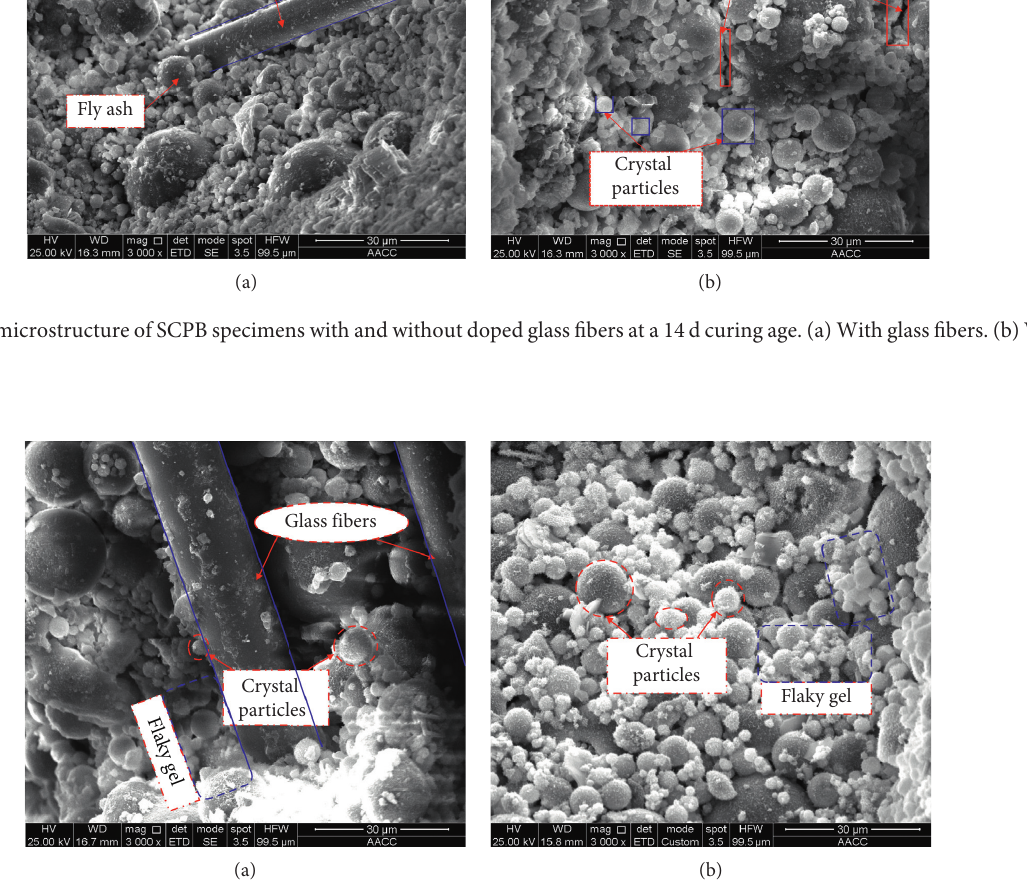
Figure 14: The microstructure of SCPB specimens with and without doped glass fibers at a 60d curing age. (a) With glass fibers. (b) Without glass fibers.